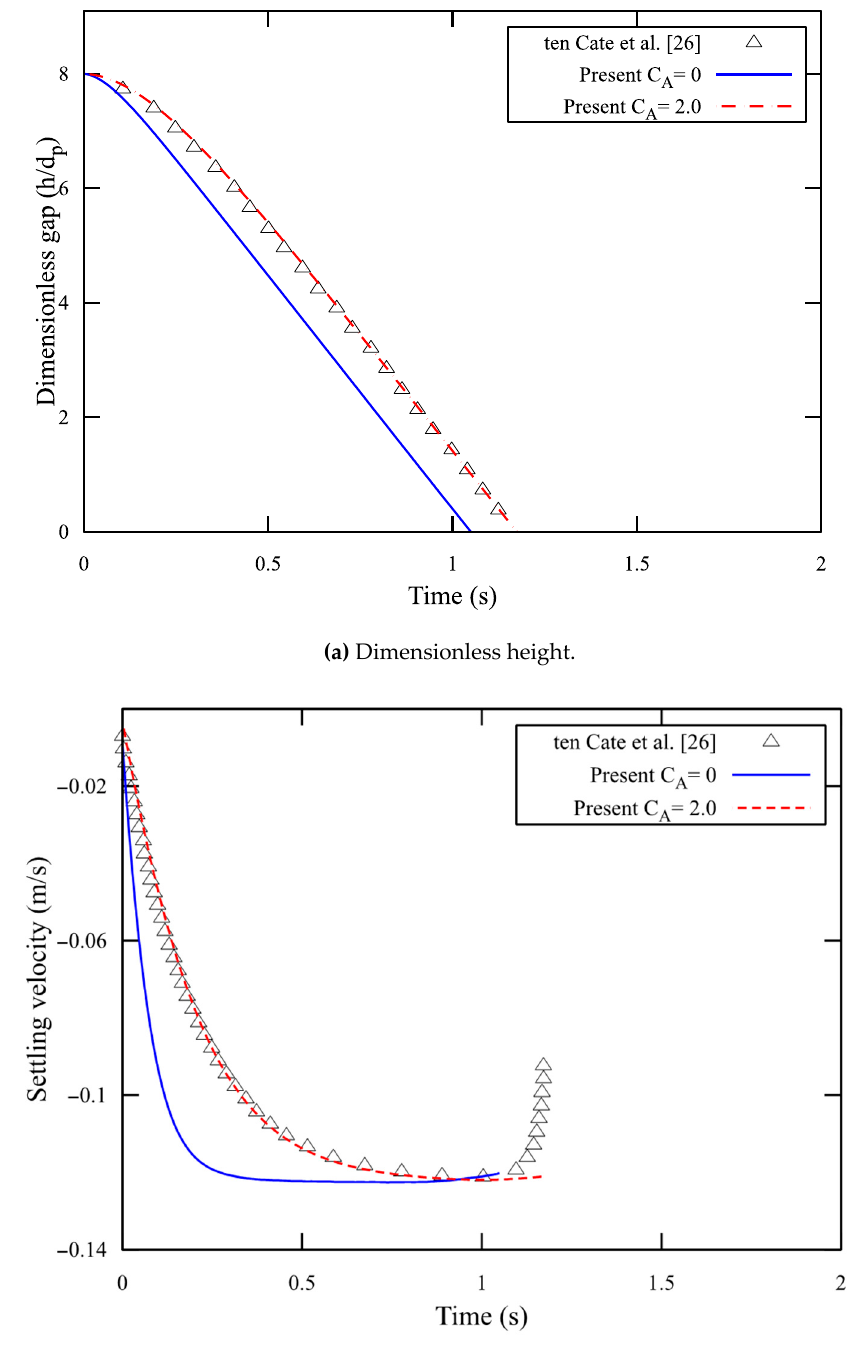
Figure 12. Particle trajectory and settling velocity. ( a ) Dimensionless height; ( b ) Settling velocity.